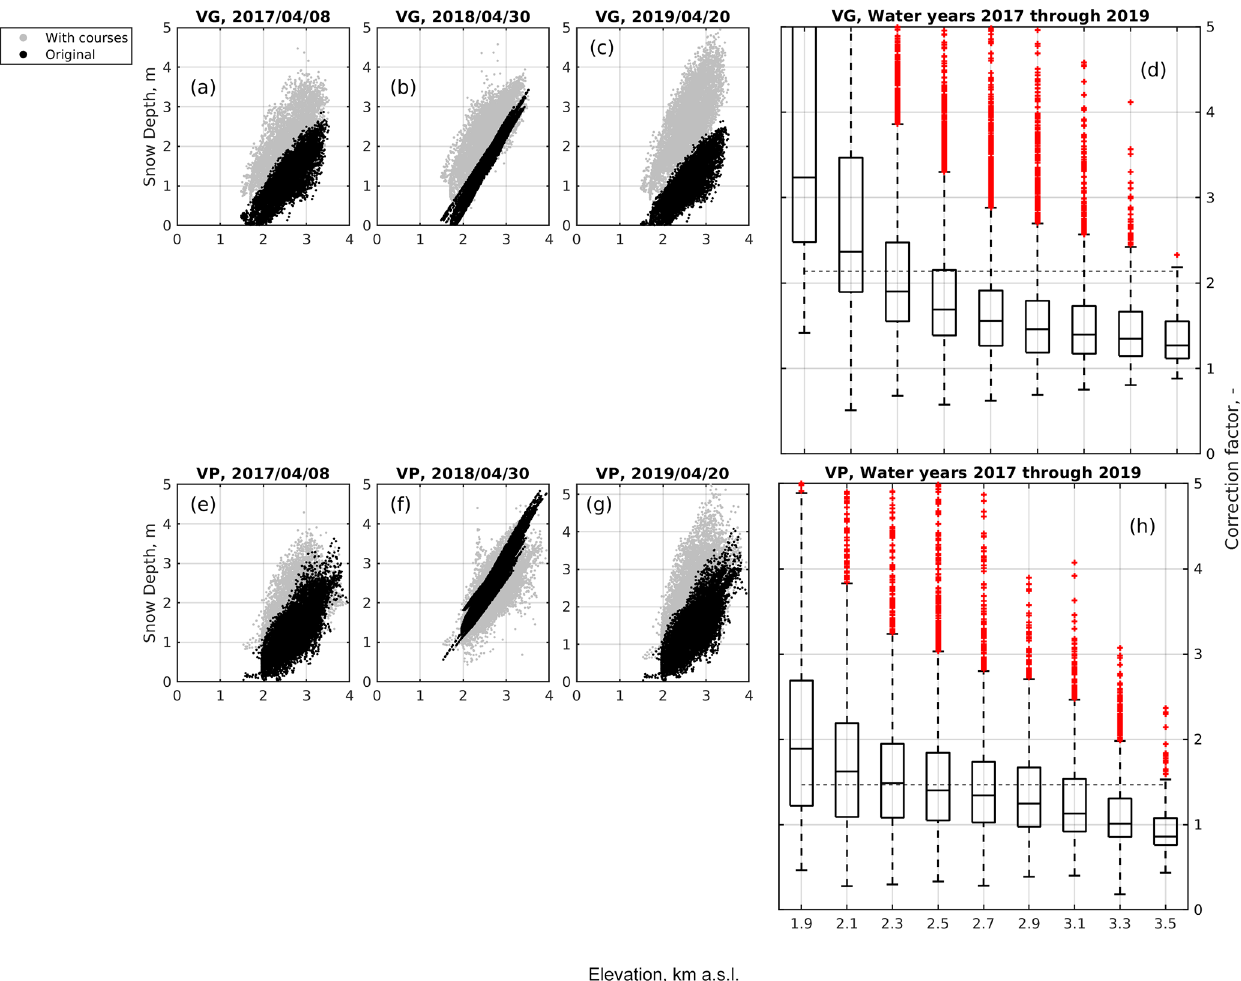
Figure 7. Orographic gradients of snow depth maps derived by only using snow depth sensors vs. those derived by including high-elevation snow courses in the calibration pool ( a to c for Beauregard and e to g for Valpelline). Panels (d) and (h) show the orographic trend of the ratio between maps derived by including snow courses in the calibration pool and those derived by only using snow depth sensors. VG and VP are Beauregard and Valpelline,